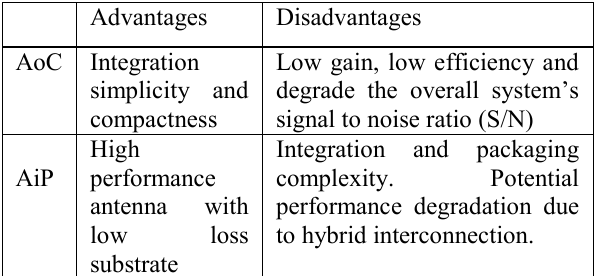
Table 4: Advantages and disadvantages of AiP and AoC